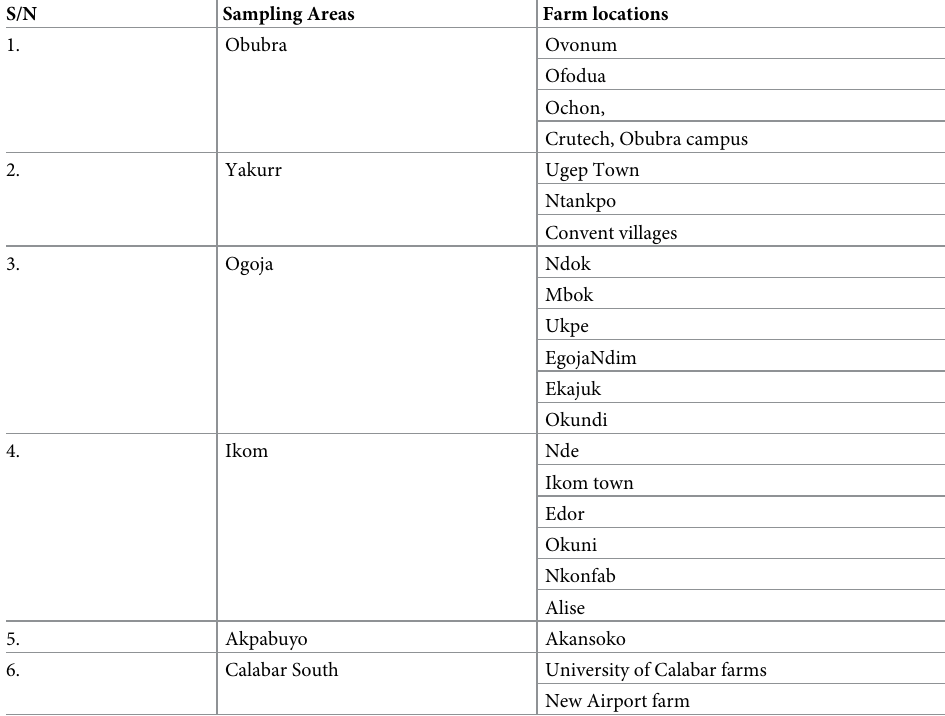
Table 1. Locations where yam farms were surveyed, and symptomatic leaves